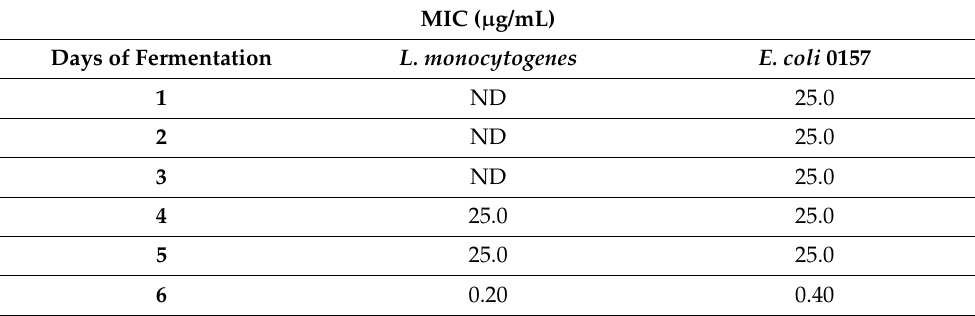
Figure 1. Lactose and lactic acid quantified in whey fermented over 6 days with Lactococcus lactis subsp. lactis , Lactococcus lactis subsp. cremoris , Lactococcus lactis subsp. lactis biovar diacetylactis , Streptococcus thermophilus , and Lactobacillus delbrueckii subsp. bulgaricus . Values are an average of at least 3 replicates ± SD. Table 1. Minimal inhibitory concentrations (MICs) of whey samples, determined against the model species L. monocytogenes and E. coli O157. Whey was collected throughout the 6 days of whey fermen- tation and was tested using the microdilution method. MICs were determined as the concentration required to reduce bacterial growth to 90%. Bacterial growth was determined by absorbance at 546 nm, and percentages were determined as a percentage of controls (bacterial growth with no whey present). Values are expressed in µ g/mL for each whey sample collected. ND = not